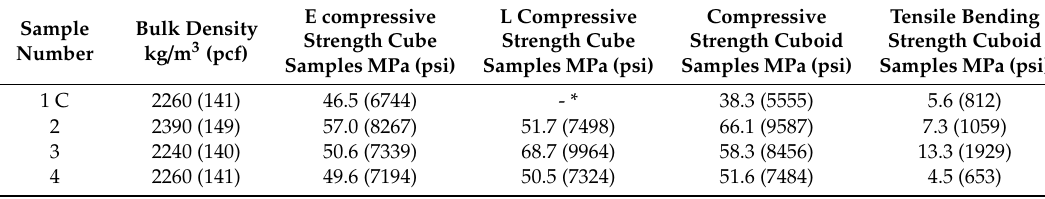
Table 5. Mechanical tests of the sulfur–concrete composites.